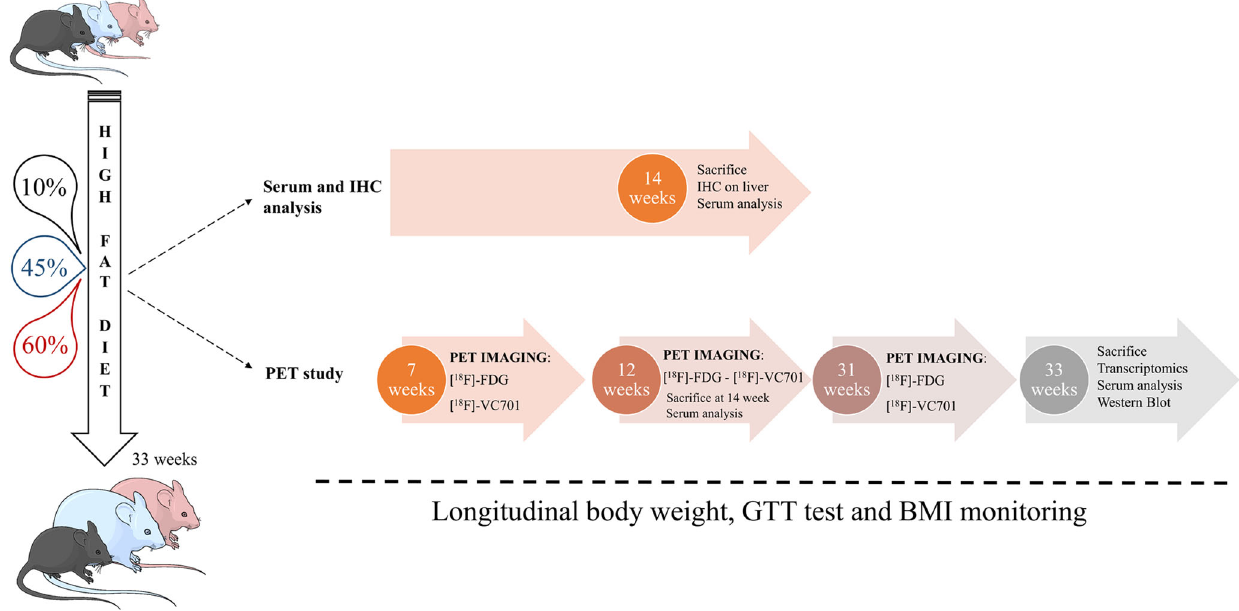
Fig. 8 Schematic representation of the experimental study design showing on the left the three experimental groups fed with three different diets varying in their lipidic contents (10% STD, 45% HFD45, 60% HFD60). On the right, a diagram represents the studies conducted on the three experimental groups and the time points. Two main sets of experiments were conducted, as indicated by the arrows. In the fi rst experiment, animals on the three diet regimens were sacri fi ced at 14 weeks and analyzed for biochemical parameters (serum evaluation) and liver immunohistochemistry (IHC); in the second experiment, animals underwent longitudinal PET imaging studies and were sacri fi ced at 33 weeks of the diet regimen for ex vivo investigation including transcriptomic, biochemical serum evaluation and western blotting. All the animals used in the study were monitored longitudinally for body weight, glucose tolerance and body mass index Information Table 2. On the basis of the presence of multiple outcomes, minimum sample size was calculated using the resource equation 66 . Metabolic evaluation . Mice were monitored for IP-GTT at 31 weeks. Basal gly- cemia was measured during fasting conditions at the end of PET-FDG studies, collecting a blood drop from the tail, after application of local anesthetic, using a glucometer (StatStrip Xpress ® 2, Nova Biomedical, MA, USA) at 0 (before glucose injection), 15, 30, 45, 60, and 120 min after i.p. glucose injection (2 gkg − 1 of bw, dissolved in saline). Hemato-chemical serum analyses . Serum analyses were performed at 14 and 33 weeks of diet. Immediately after sacri fi ce by vertebral dislocation after a light iso fl urane anesthesia (2% in air), blood was collected by heart puncture into Eppendorf tubes, clotted for 30 min and serum collected by centrifugation (1300× g , 10min). Samples were stored at − 80°C until use. Total cholesterol (mgdL − 1 ), HDL, (mgdL − 1 ), LDL (mgdL − 1 ), aspartate aminotransferase (AST; UIL − 1 ), alanine aminotransferase (ALT; UIL − 1 ) and albumin (gdL − 1 ) were determined by the LAM Service (Laboratory of Murine Analyses facility) at our